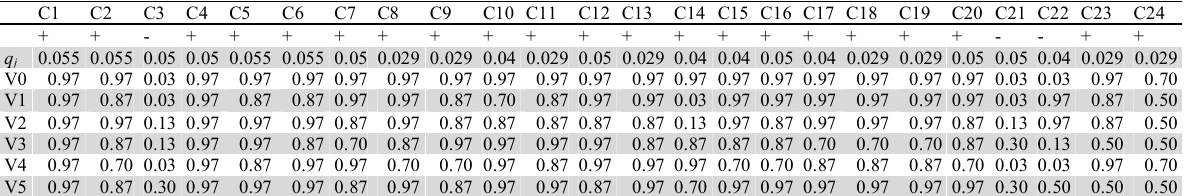
Defuzzyfied Decision Matrix